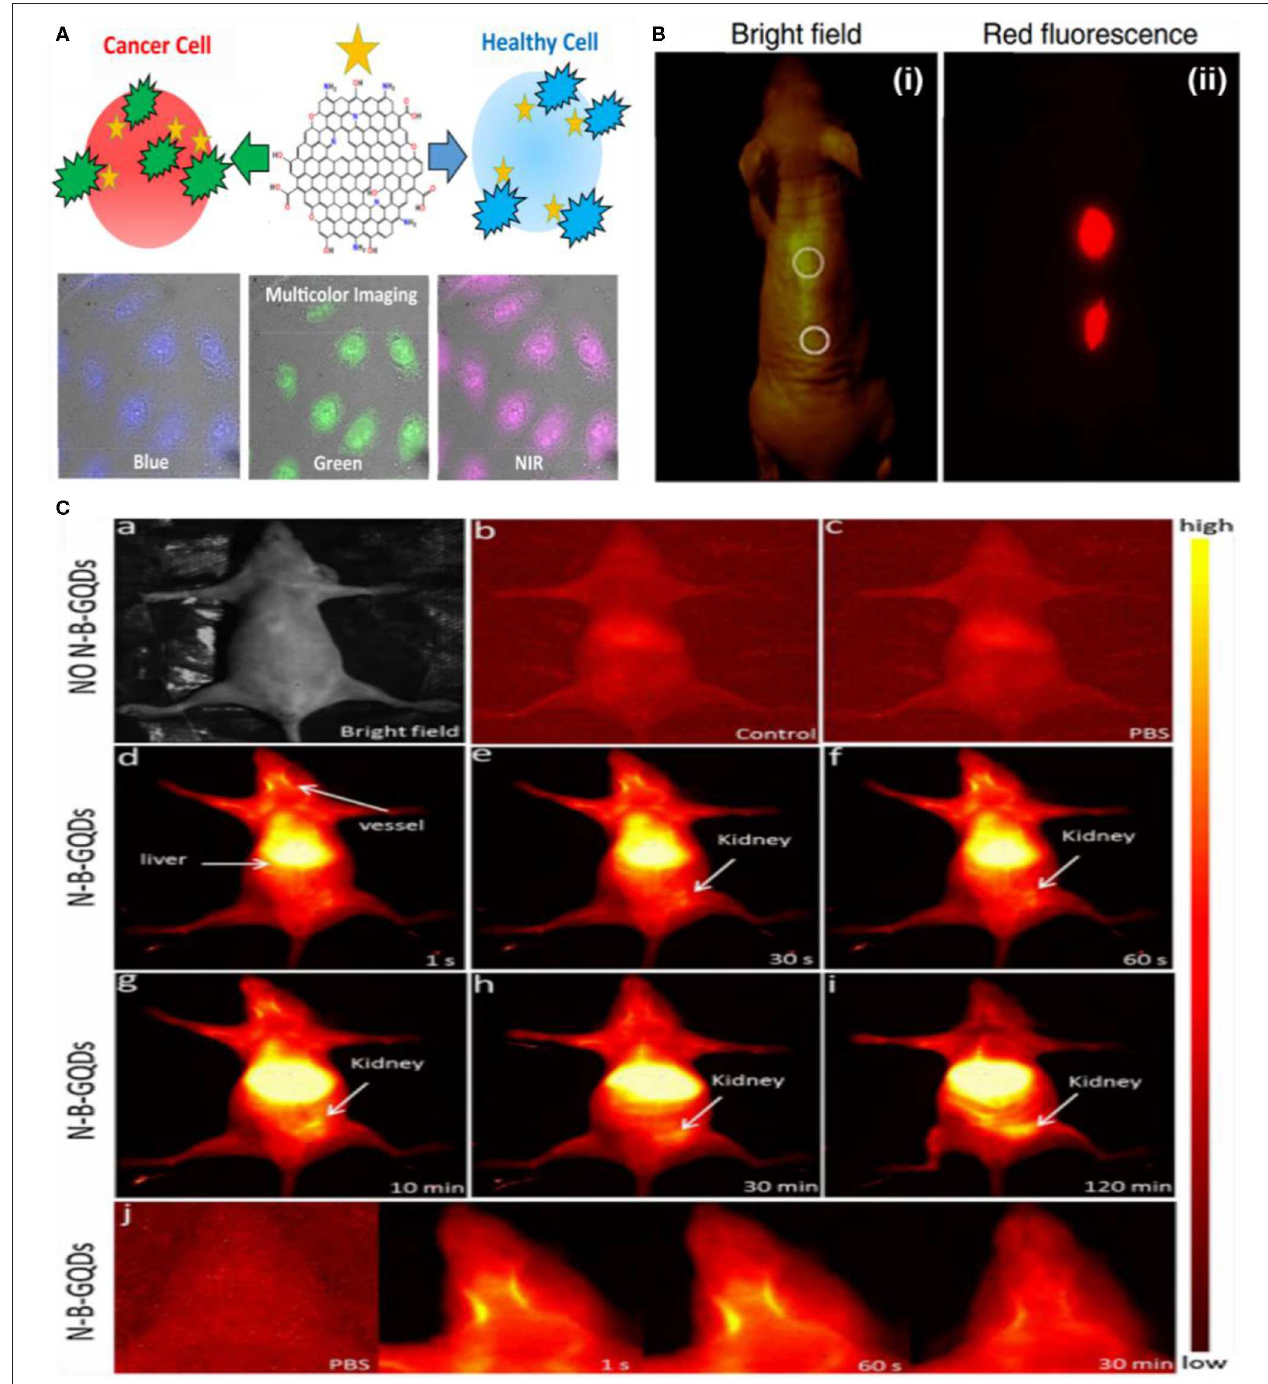
FIGURE 10 | (A) Representation of heteroatom-doped GQDs for multicolor imaging and cancer cell detection; reproduced from Campbell et al. (2019) with permission from the American Chemical Society. (B) Bright-field (i) and (ii) in vivo red-fluorescence image of GQDs after subcutaneous injection; reproduced from Ge et al. (2014) with permission from Nature Publishing Group. (C) NIR-II in vivo imaging of live mice in supine position; reproduced from Wang et al. (2019b) with permission from Elsevier. (a) Digital image of a nude mouse. (b,c) NIR-II imaging of a control either without injection or with only PBS. (d–i) NIR-II imaging of nude mice at mentioned time points after an i.v. injection of N,B co-doped GQDs (1 mg/ml, 200L). (j) Higher magnified NIR-II images captured at indicated time points, showing blood vessels in the head. The PBS group was used as a control.